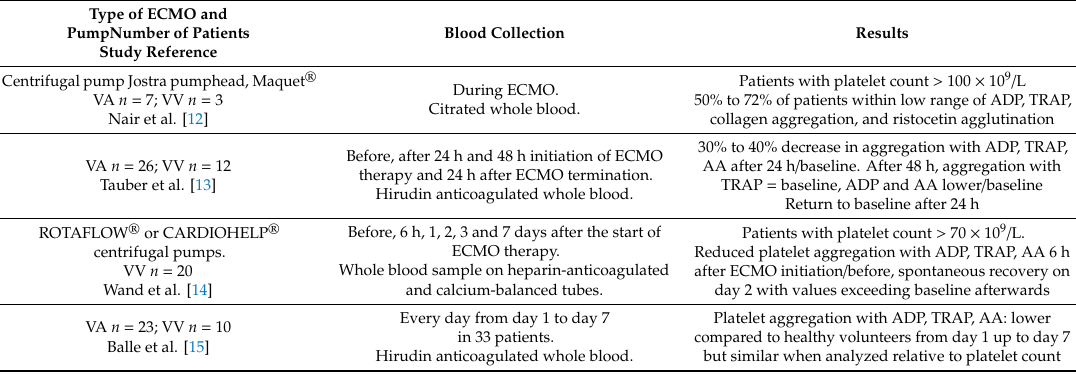
Table 1. Main results of platelet aggregation studies with Multiplate ®